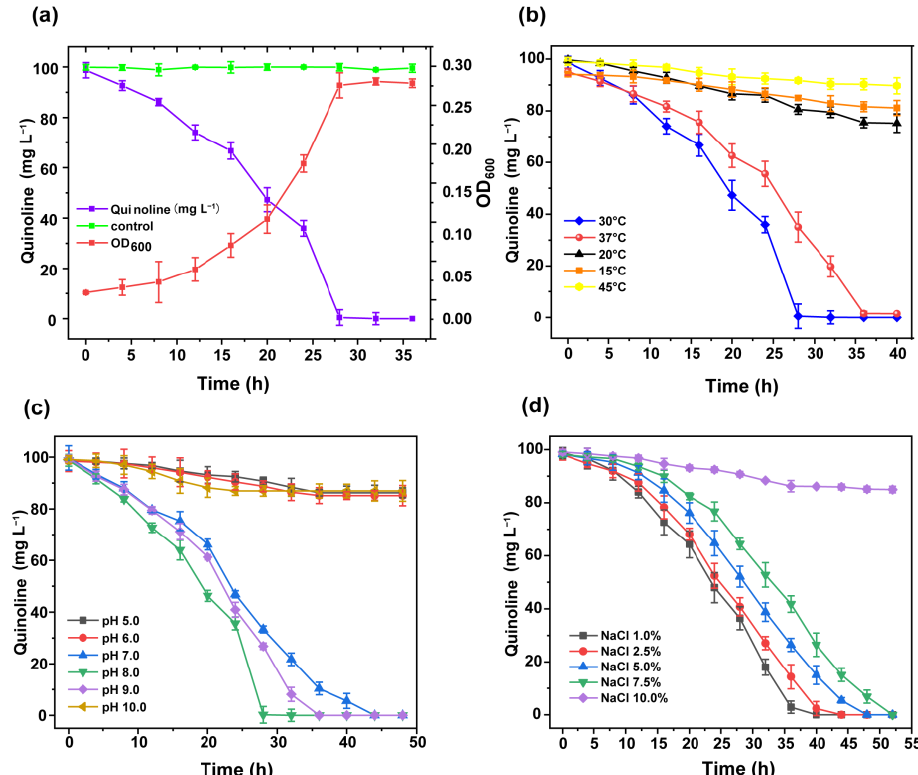
Figure 2. Effect of JH145 on quinoline degradation under different conditions ( a ) The cell growth and degradation characteristics of strain JH145 with quinoline as the sole carbon source. ( b ) Effects of temperature on the quinoline biodegradation of strain JH145. ( c ) Effects of initial pH on the quinoline biodegradation of strain JH145. ( d ) Effects of NaCl on the quinoline biodegradation of strain JH145.